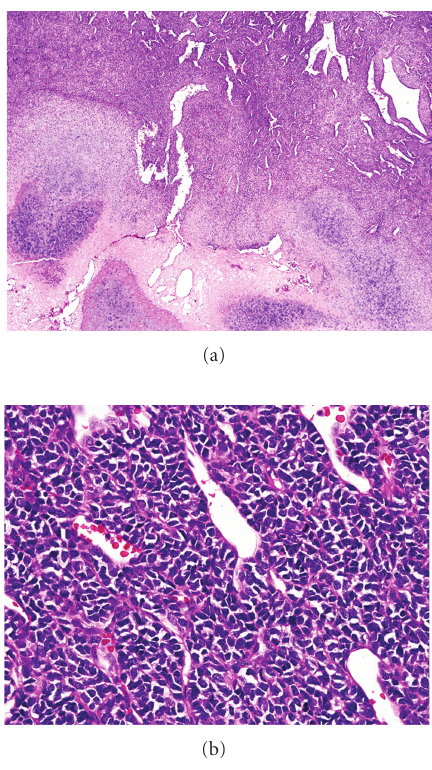
Figure 12: (a) Mesenchymal CHS showing bimorphic pattern, consisting of islands of hyaline cartilage and undi ff erentiated cells. Note hemangiopericytomatous vascular pattern. (b) The undi ff erentiated small cells with relatively uniform oval to round nuclei and scanty amount of cytoplasm.